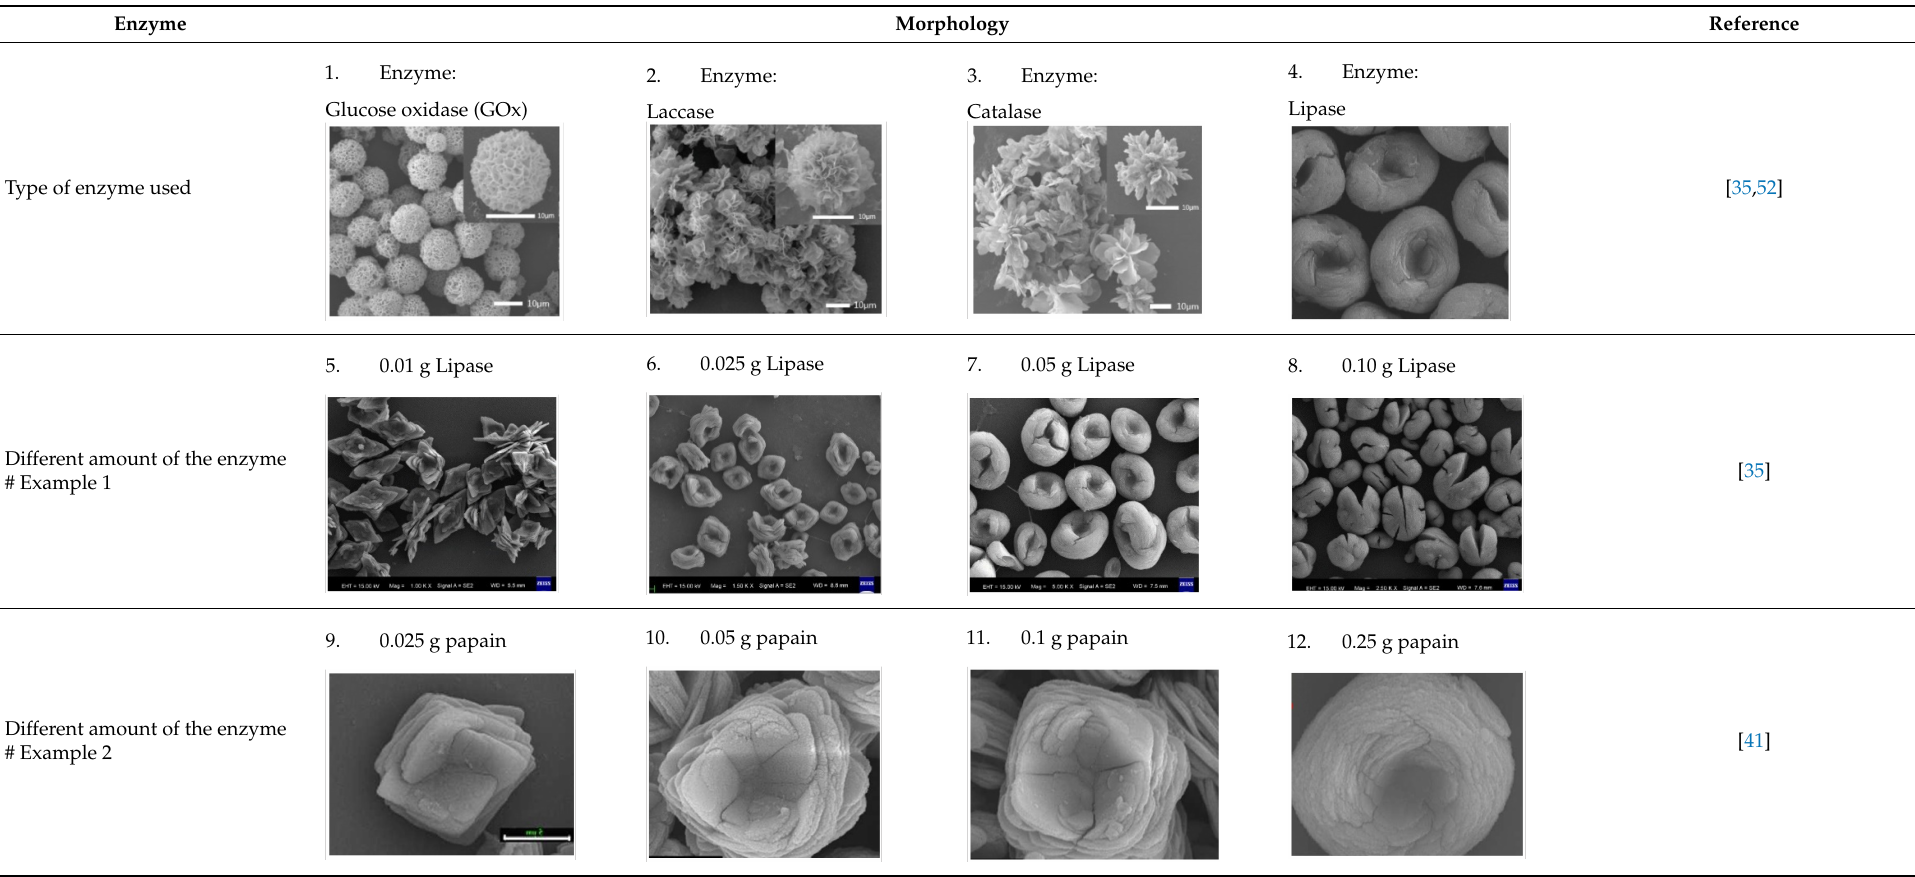
Table 3. Different factors and conditions that affect the morphology of